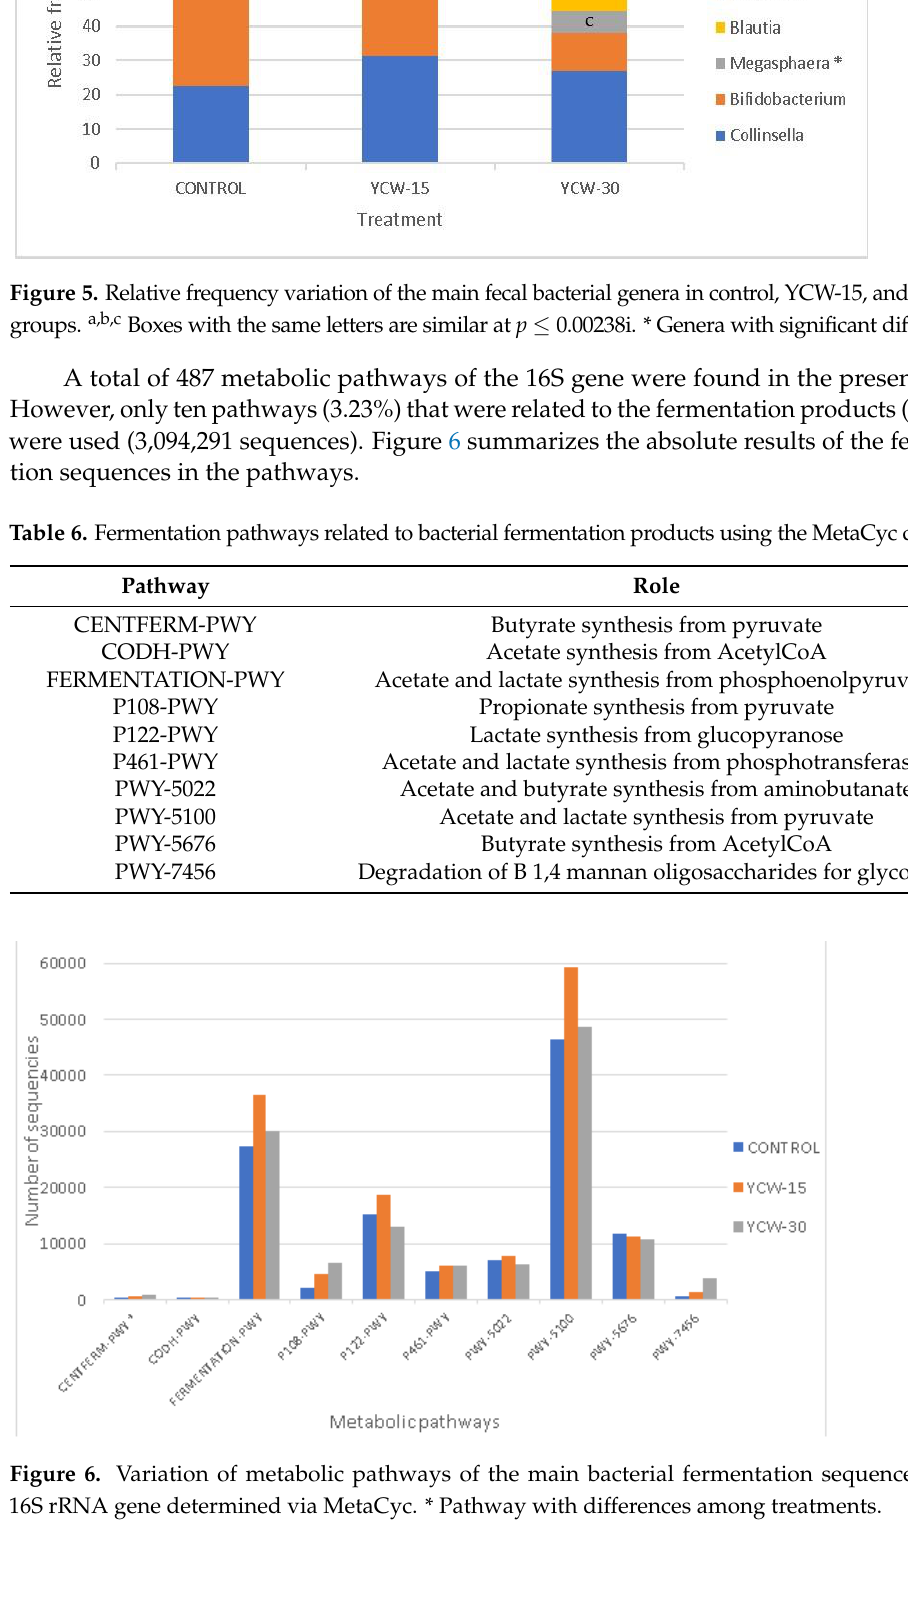
Figure 7. Median differences (absolute values) among treatments in the metabolic pathway CENT- FERM-PWY. a,b Boxplots with the same letters are similar at p ≤ 0.1.